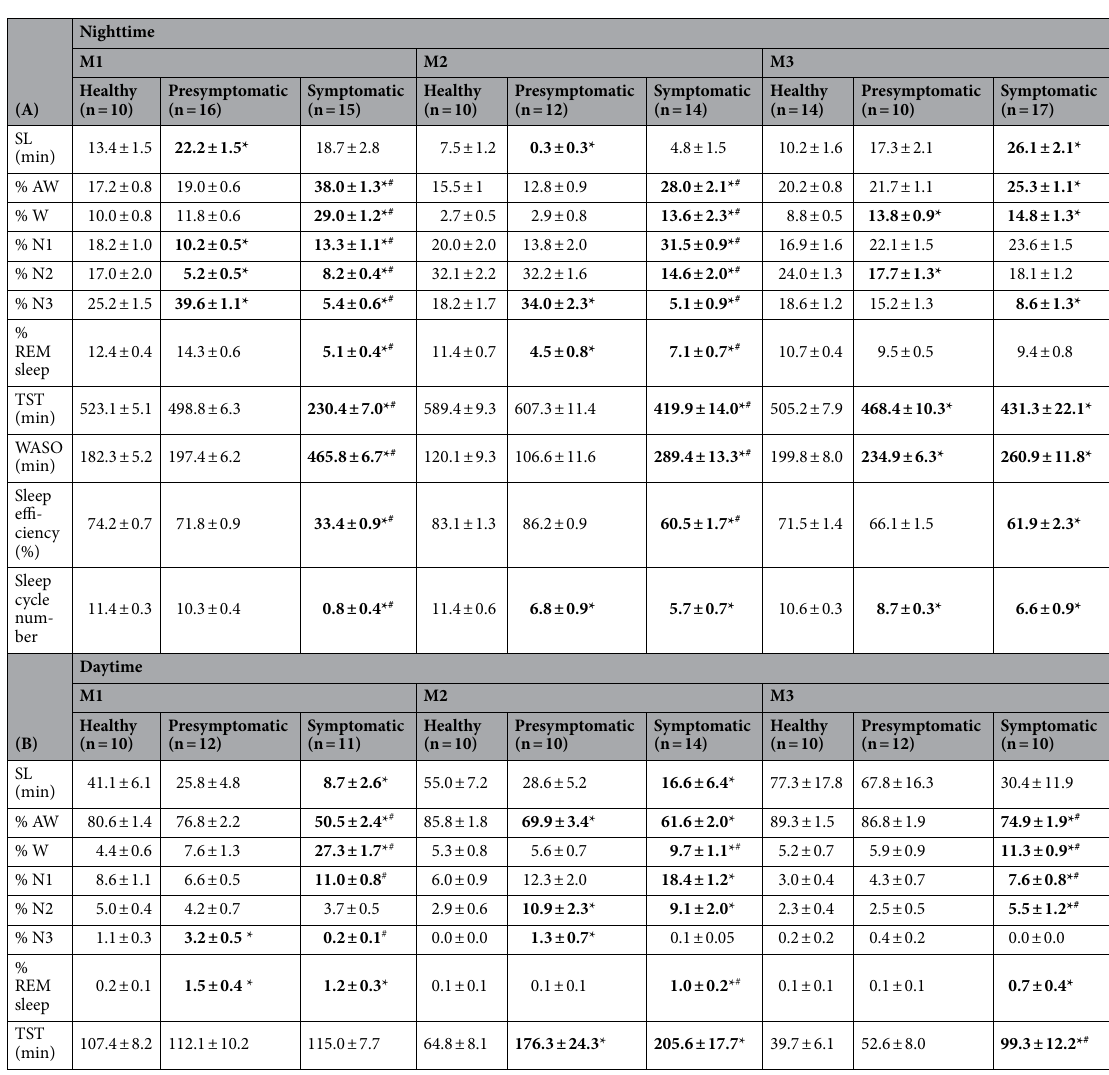
Table 1. Sleep parameters from long-term 12 h recordings of nighttime and daytime for each animal during healthy, presymptomatic and symptomatic states. ( A ) Each column represents mean values (± SEM) derived from healthy, presymptomatic and symptomatic nights (n are indicated in parentheses) for M1, M2 and M3. SL correspond to the time in minute between lights turned off (7 pm) and the first sleep episode. Values in lines 2, 3, 4 and 5 are expressed as the mean percentage of the total scoring time with AW = active wake, W = quiet wake, N1, N2, N3 = Non-REM sleep stage 1, 2 and 3 respectively and REM sleep. TST refers to the total sleep time during the night i.e. between 7 p.m. and 7 a.m. Wake time after sleep onset (WASO) is expressed in minute and refers to the sleep period time minus the TST. Sleep efficiency, expressed in %, as the ratio of TST to the sleep period time. ( B ) Each column represents mean values (± SEM) derived from healthy, presymptomatic and symptomatic days (n are indicated in parentheses) for M1, M2 and M3. Sleep latency (SL) refer to the first sleep after wake and TST refer to the total sleep time during the day. Each sleep and wake stages are expressed in mean percentage of the total scoring time. *p < 0.05: Kruskal–Wallis test followed by Dunn’s multiple comparisons test in the event of statistically significant differences. Significant values are in